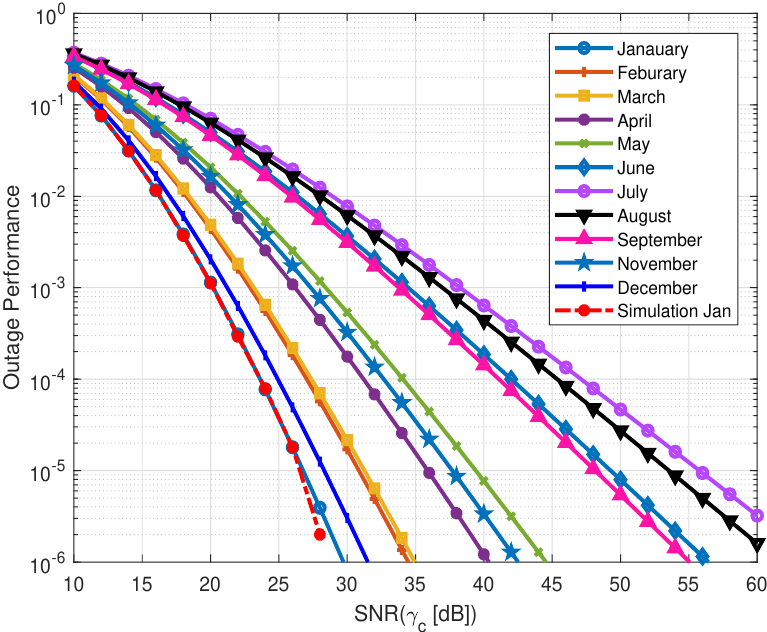
Figure 7. The observation of outage performance for whole year depicted in Baltic Sea. The simulated outage performance included as in February. The outage performance is simulated based on the experimental data provided though the year.